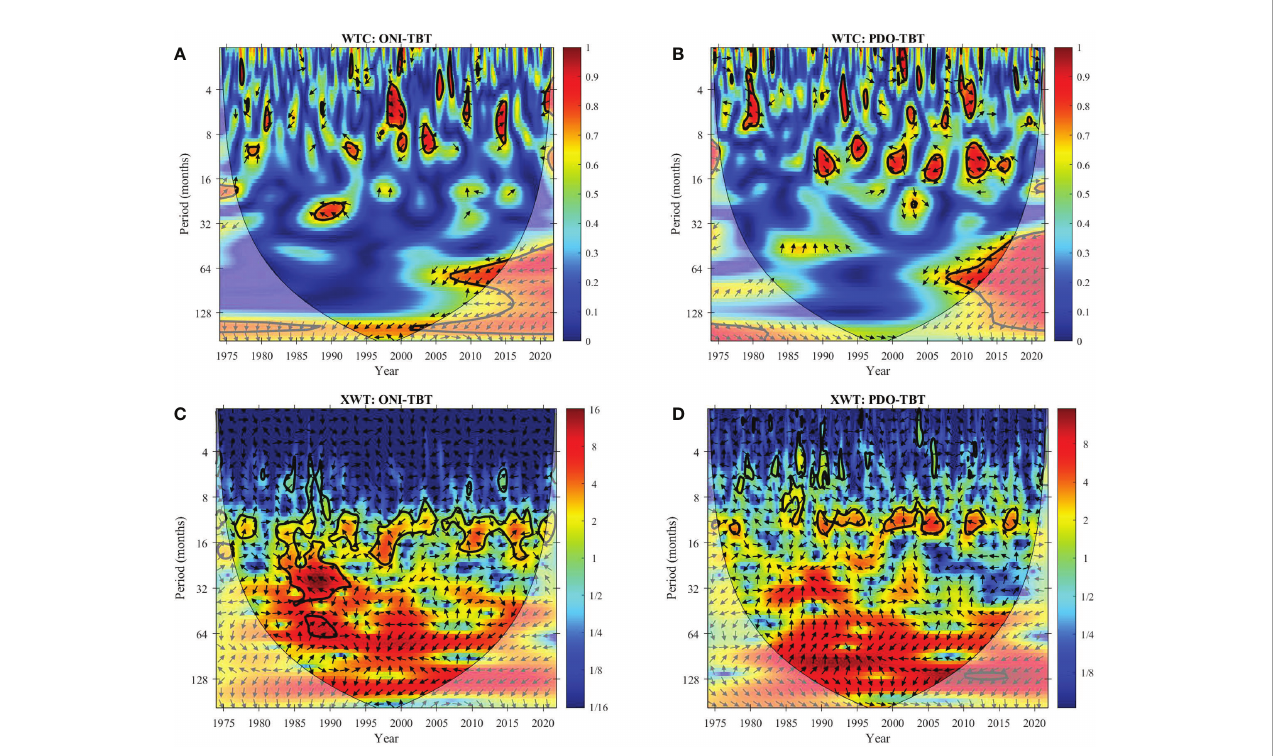
FIGURE 10 WTC and XWT spectrum of ocean-atmosphere variabilities and the RSL at TBT site. (A, B) are the WTC spectrums of ONI-TBT and PDO-TBT. (C, D) are the XWT spectrums of ONI-TBT and PDO-TBT.